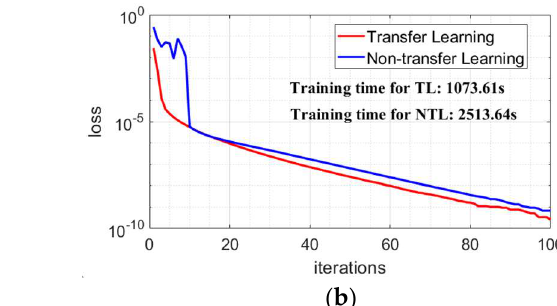
Figure 13. The loss of transfer learning and non-transfer learning in the model training process. The